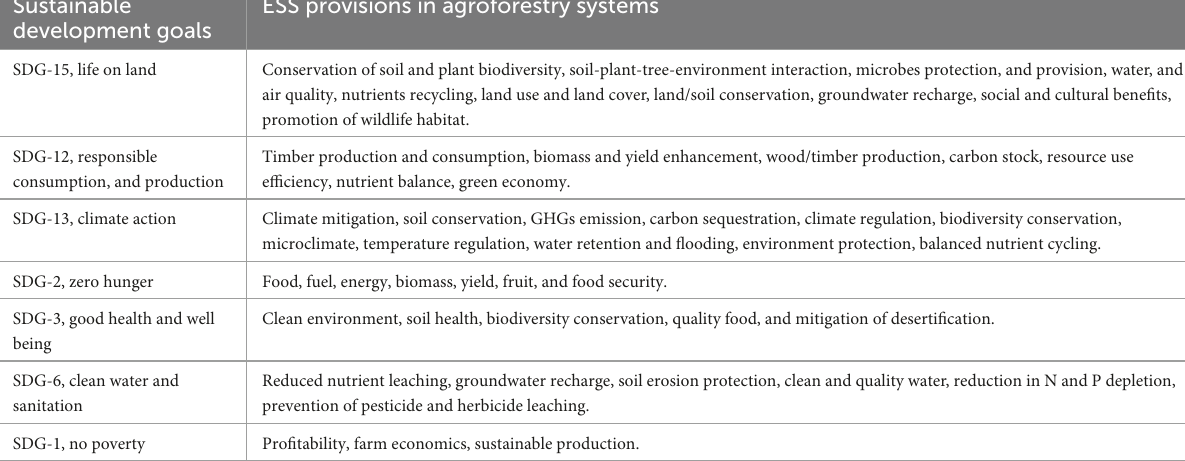
TABLE 1 Ecosystem services (ESS) need to be simulated using optimized agroforestry system (AFS) models and modeling frameworks according to the sustainable development goals of the United Nations. Sustainable ESS provisions in agroforestry systems development goals SDG-15, life on land Conservation of soil and plant biodiversity, soil-plant-tree-environment interaction, microbes protection, and provision, water, and air quality, nutrients recycling, land use and land cover, land/soil conservation, groundwater recharge, social and cultural benefits, promotion of wildlife